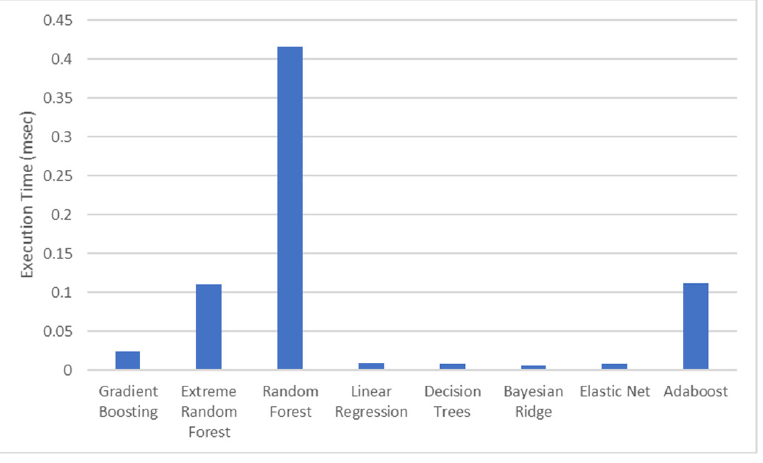
Figure 10. The average execution time of the machine learning algorithms that are used for regression for test for DBpedia v3.8.